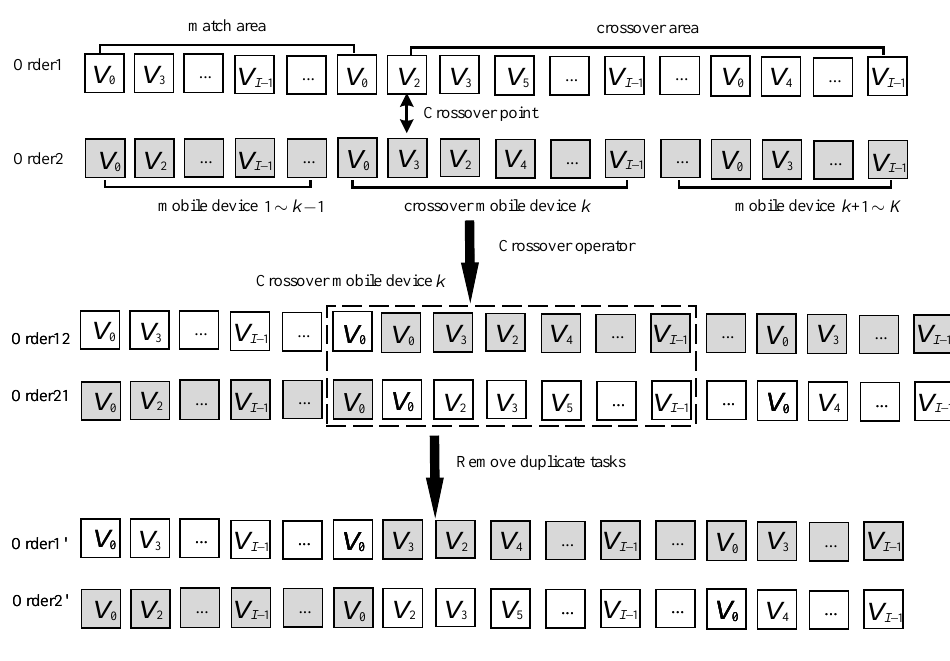
Figure 5. The single − point crossover operation of task execution order.